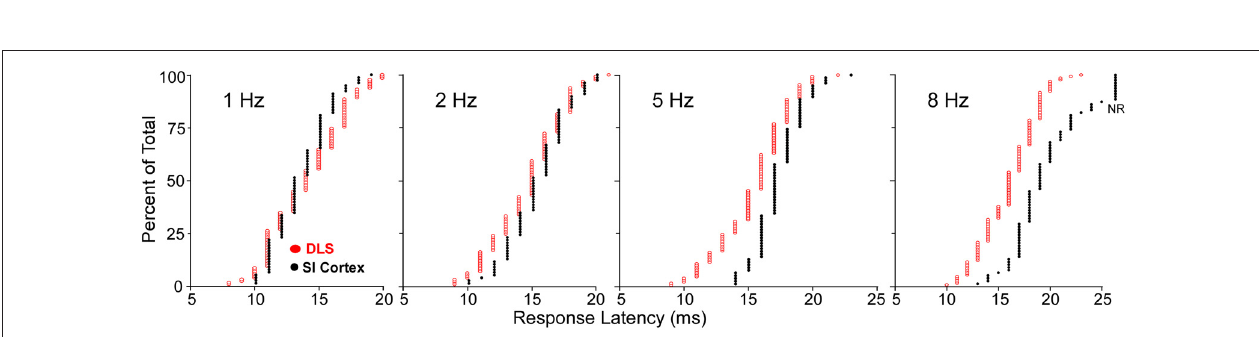
FIGURE 6 | Cumulative distributions of response latencies of regular spiking and medium spiny neurons (MSNs) recorded, respectively, in SI and DLS during whisker deflections at different frequencies. At 8-Hz, nonresponsive neurons in SI are depicted by NR. Adapted from Mowery et al. (2011).